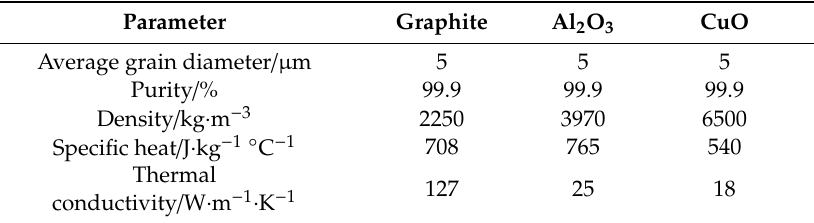
Table 1. Parameters of the microparticles.